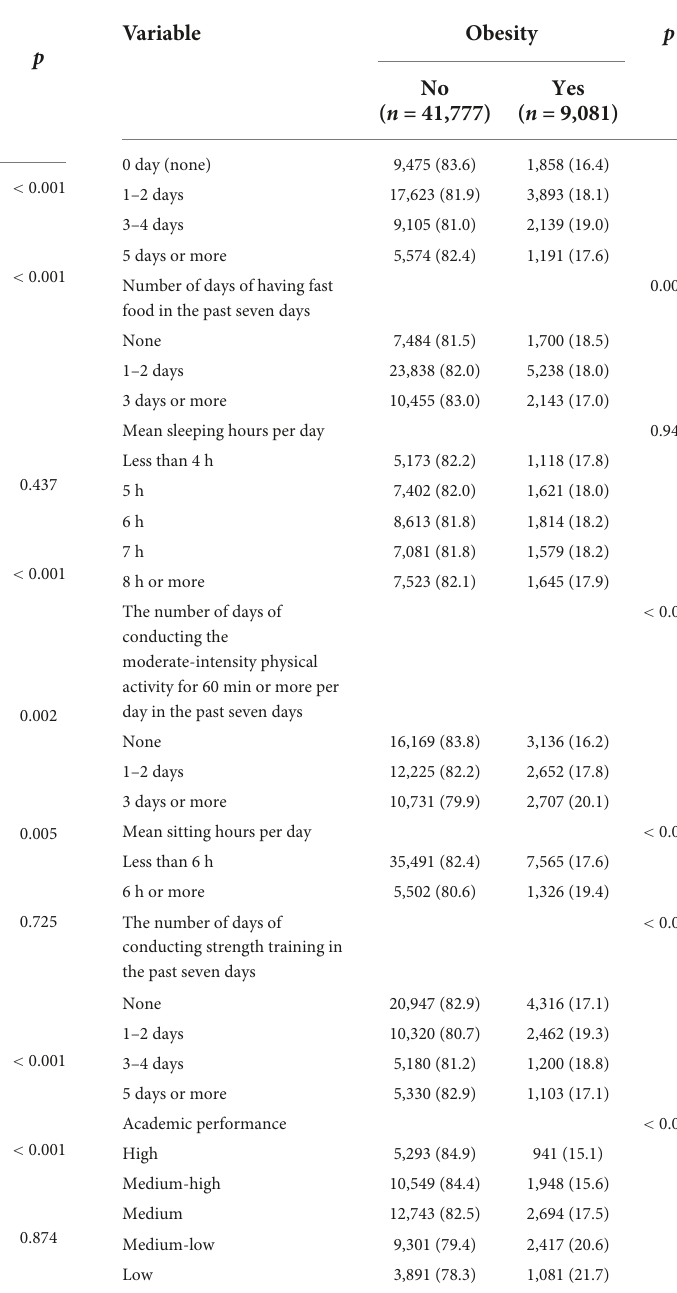
TABLE 1 General characteristics of subjects by the prevalence of obesity, n